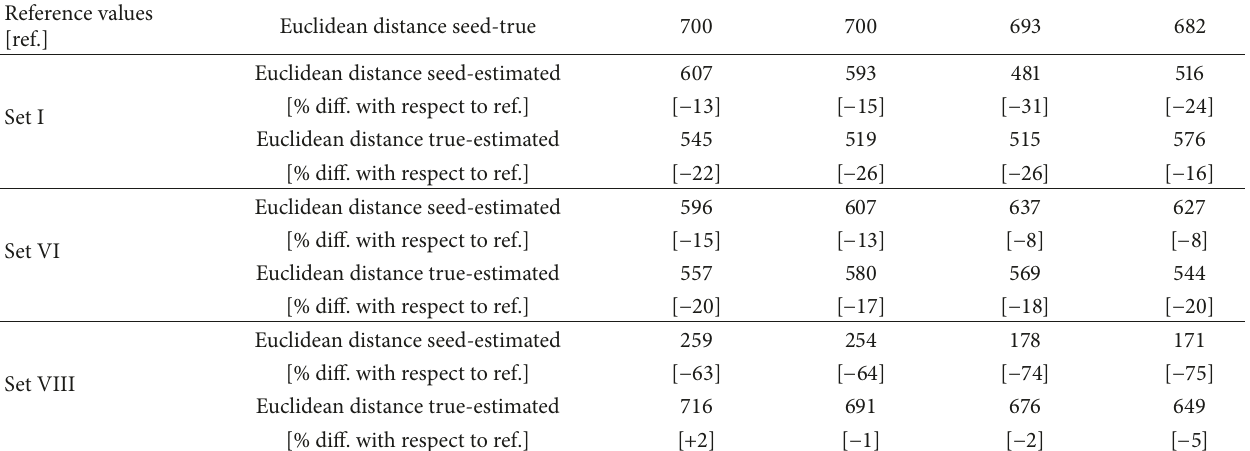
Table 10: Evaluation of the estimated demand in terms of O–D aggregated distribution in time (adding O-D travel times). Reference